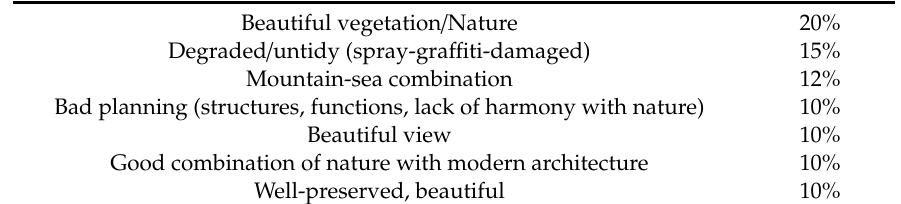
Table 6. Greek engineering students’ reasons for their characterization of the Campus landscape (2nd research